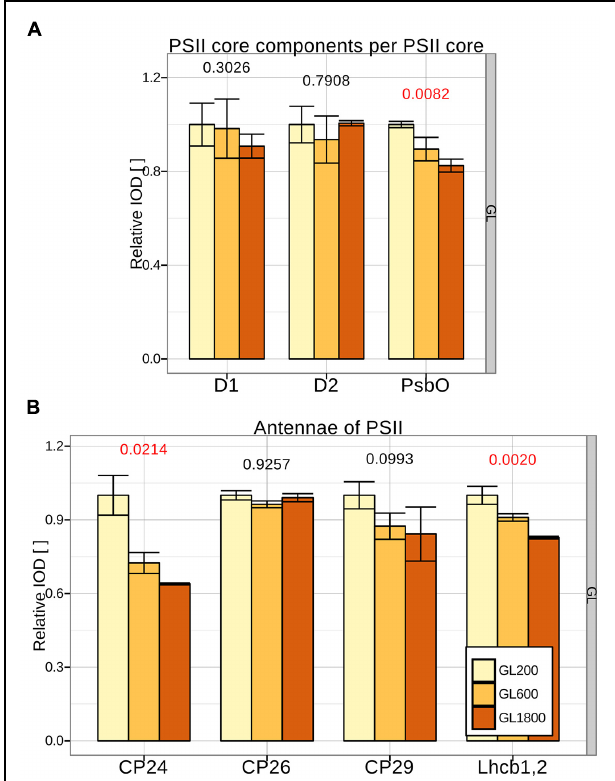
FIGURE 3 | Changes in the PSII composition during long-term acclimation to different light intensities. (A) The amount of PSII core proteins: D1, D2, and PsbO per CP43, 47 was quantified in isolated thylakoids from plants grown under GL200, 600, and 1800 (respectively, yellow, orange, and brown fill) separated during 2D-PAGE in three different repetitions ( n = 3). (B) The amount of minor PSII antennae: CP24, CP26, CP29, and Lhcb1,2 per PSII core was quantified in isolated thylakoids from the same samples. Numbers below the bars are the p -values of ANOVA’s F -test on a specific group. Red color signifies rejection of the null hypothesis that the response to all growth lights is the same ( α < 0.05), black its